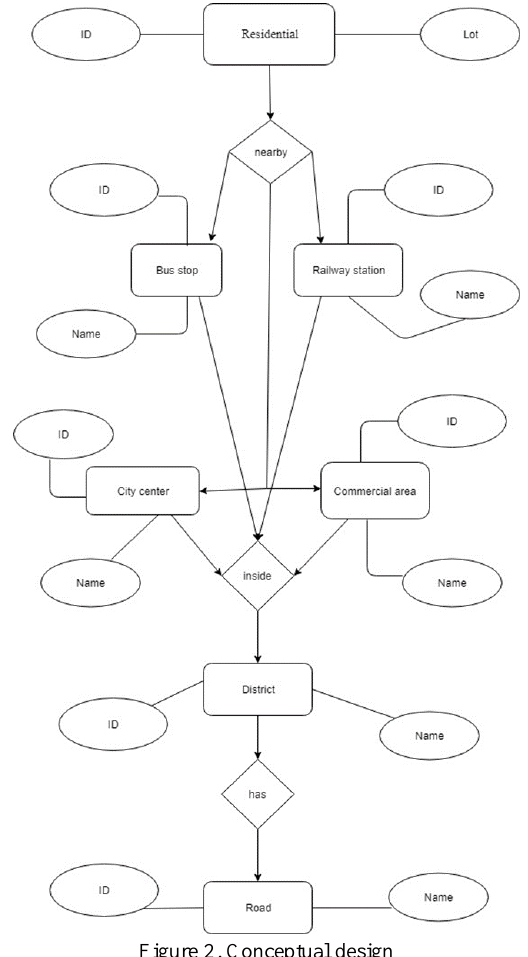
Figure 2. Conceptual